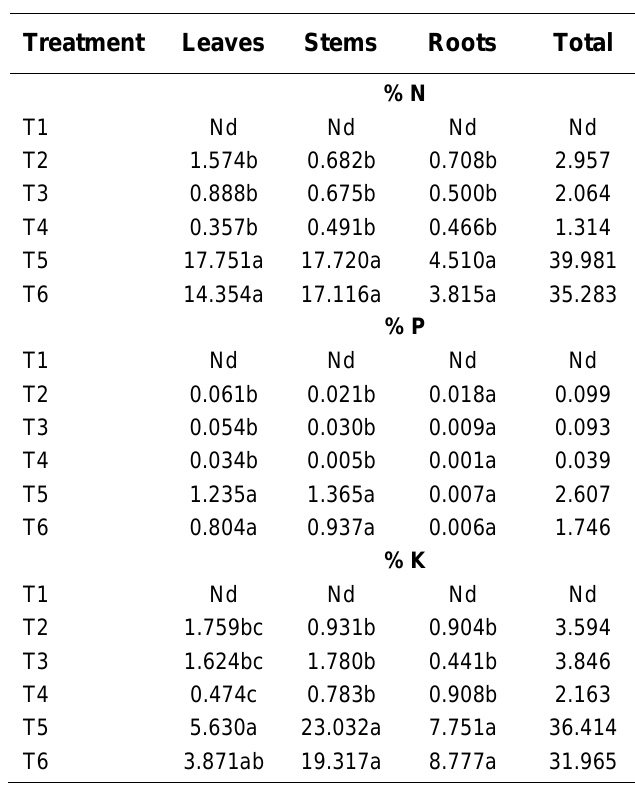
Different letters within a column indicate significant difference between means using Tukey’s test at p = 0.05. Nd, not determined.